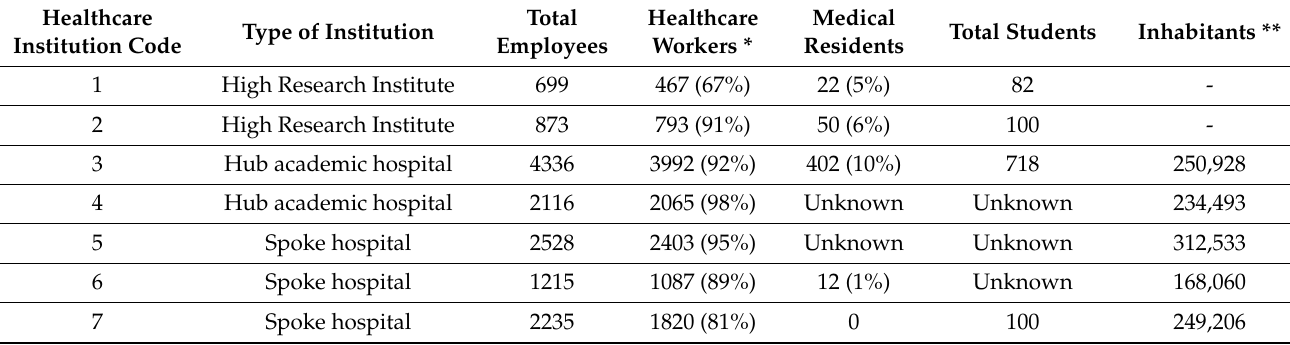
Table 1. Main healthcare institution